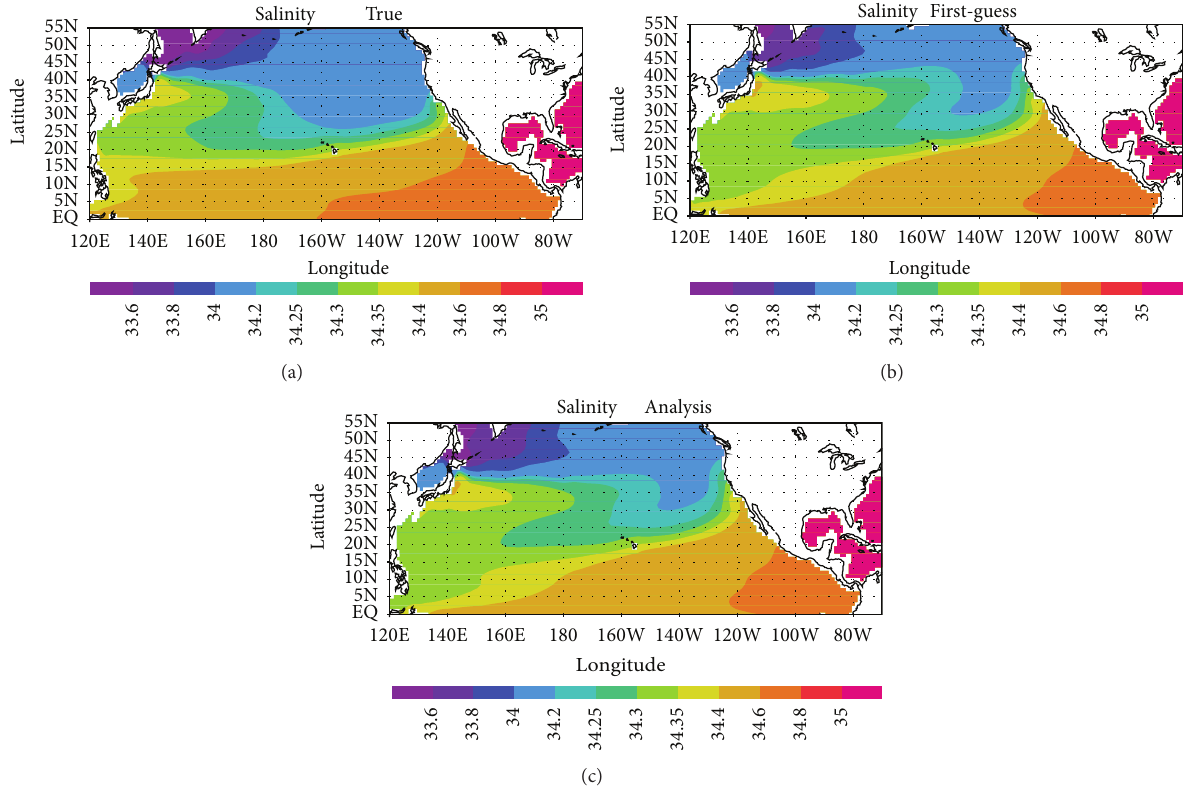
Figure 2: Distribution of salinity on the 26.8 𝜎𝜃 isopycnal surface averaged over 1995–2000: (a) true simulation for the twin experiment, (b) first-guess simulation with no observational input, and (c) analysis simulation in which the virtual concentrated observations were synthesized.